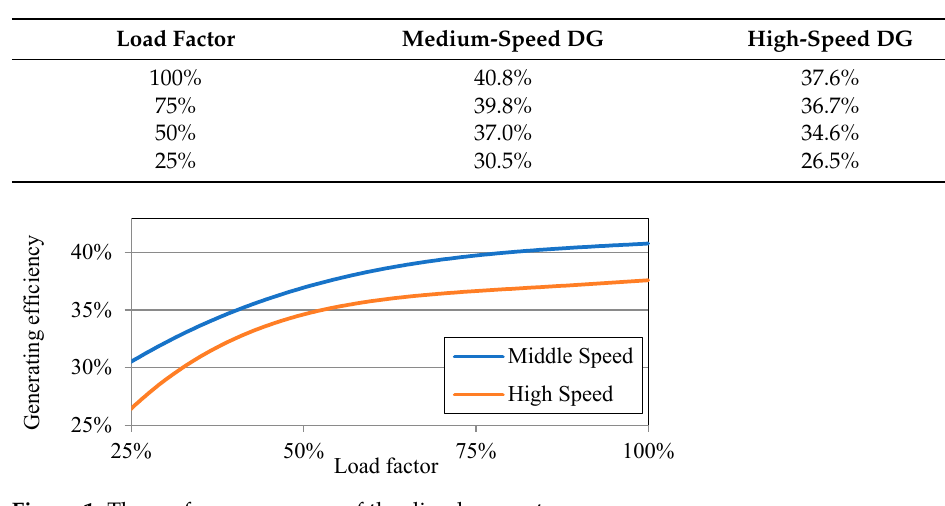
Figure 1. The performance curve of the diesel generators.